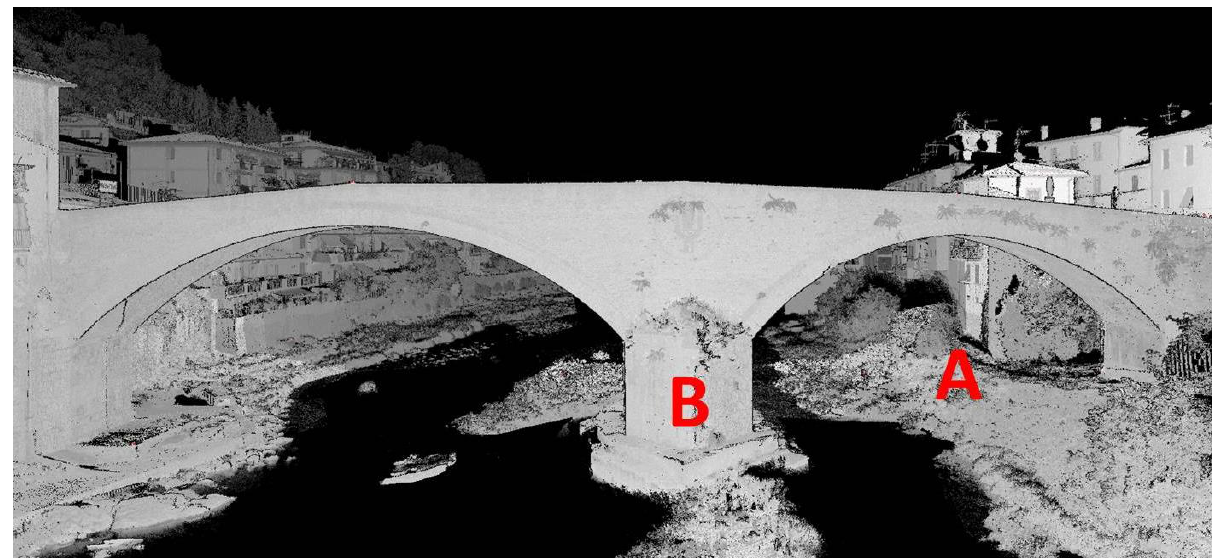
Figure 3 - Merged Point cloud from 2017 Laser Scanner campaign. A) Left span. B) Central